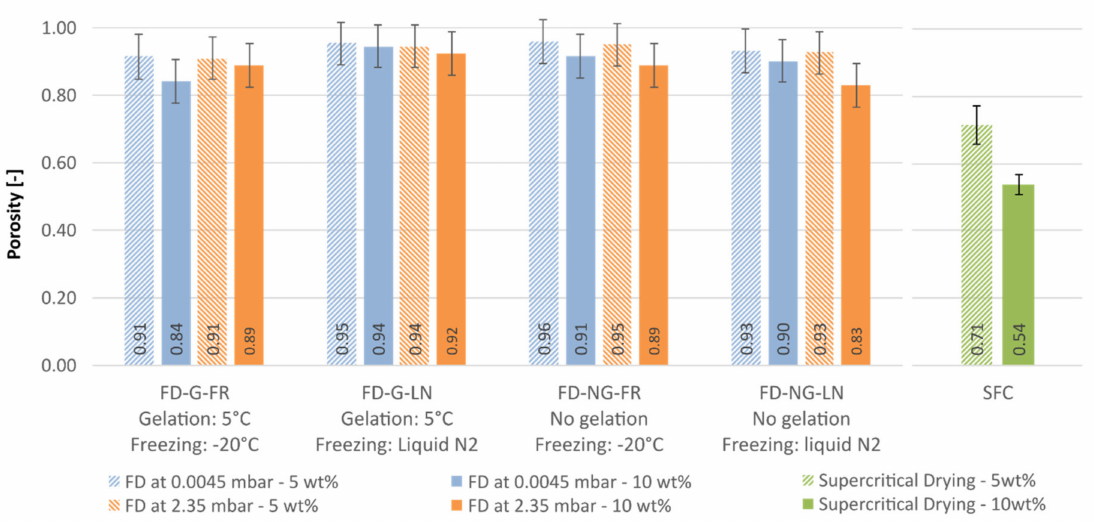
Figure 11. Porosity comparison of freeze-dried and supercritically dried samples for starch concentration of 5 w% (hashed bars) and 10 wt.% (plain bars). Table 1. Brunauer–Emmett–Teller (BET) surface area of the porous starch materials produced with freeze-drying and supercritical drying measured with nitrogen adsorption.